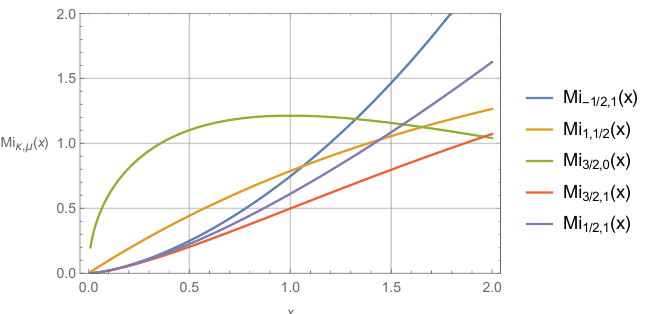
Figure 3. The integral Whittaker functions Mi κ , µ ( x ) as a function of variable x at fixed values of parameters κ and µ .